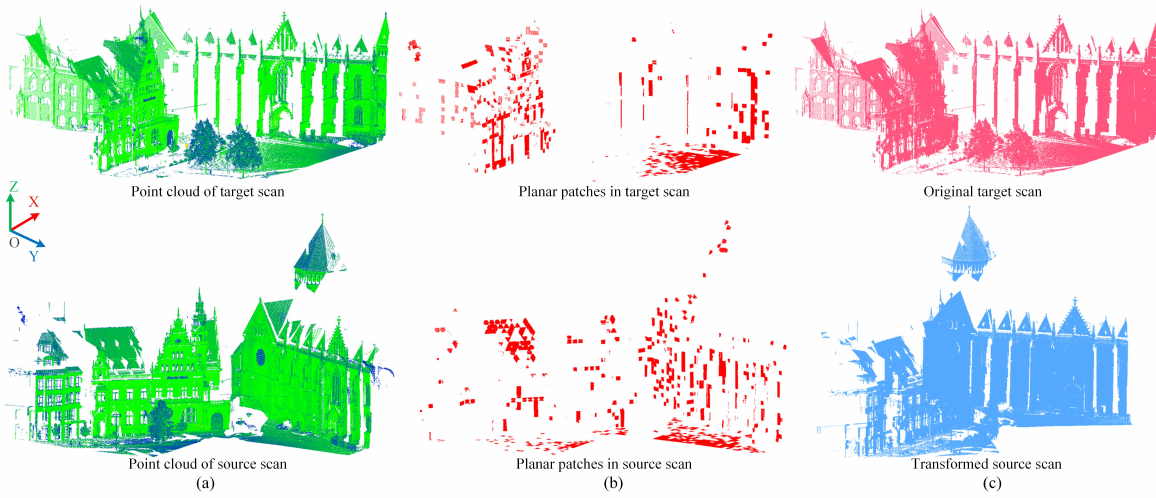
Figure 7. Registration results of Bremen datasets. (a) Original scans. (b) Extracted planar patches. (c) Aligned scans